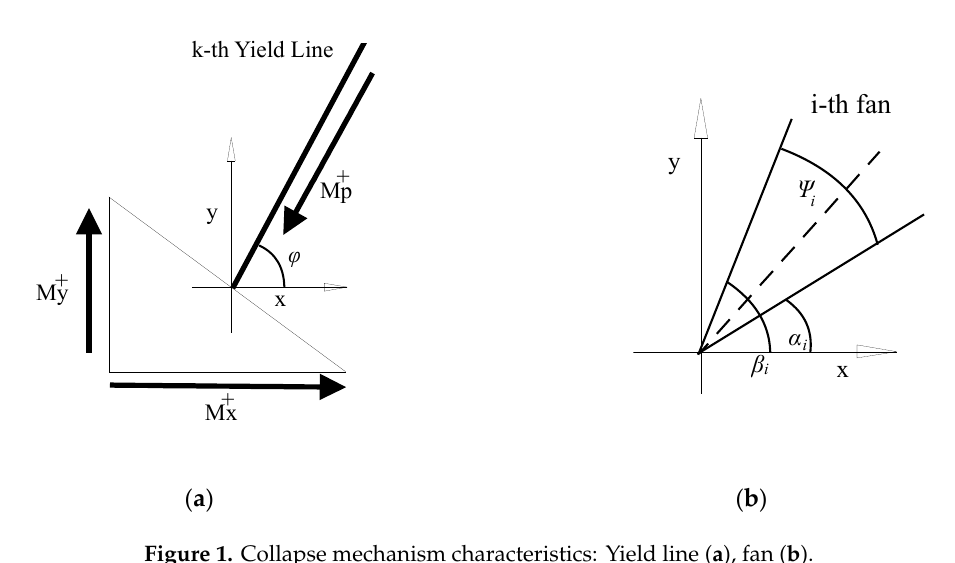
Figure 1. Collapse mechanism characteristics: Yield line (a), fan (b).